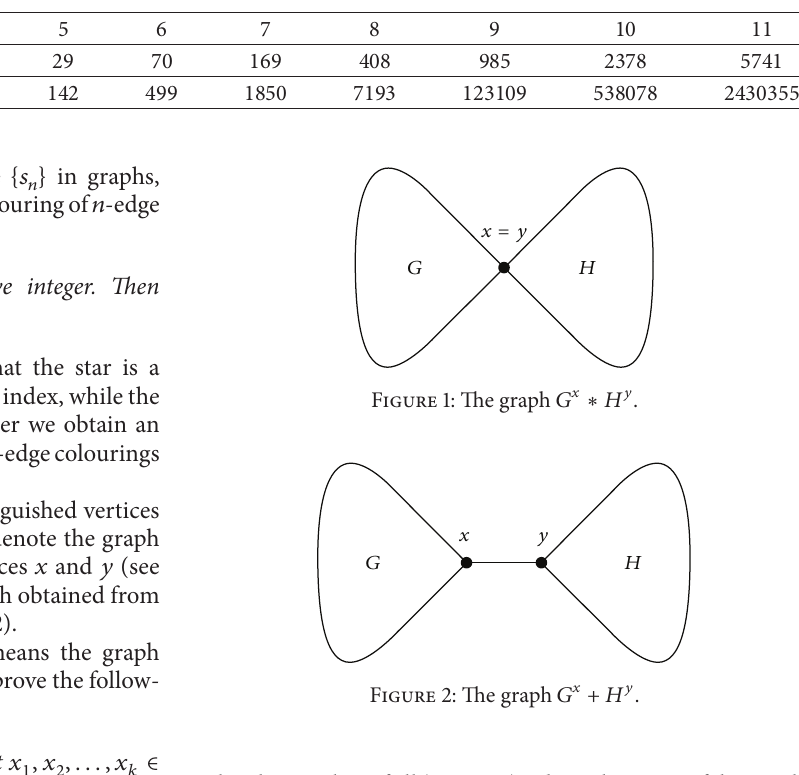
Table 1: The first terms of {𝑃 𝑛 } and {𝑠 𝑛 } .